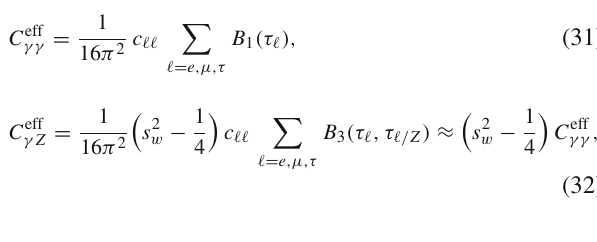
Fig. 8 Parameter regions which can be probed for e + e − → ha → b ¯ b γγ (upper panels) and e + e − → ha → b ¯ b (cid:10) + (cid:10) − (lower panels) at future e + e − colliders. The grey shaded area is excluded by LHC Higgs measurements. The parameter space to the right of the dotted contours